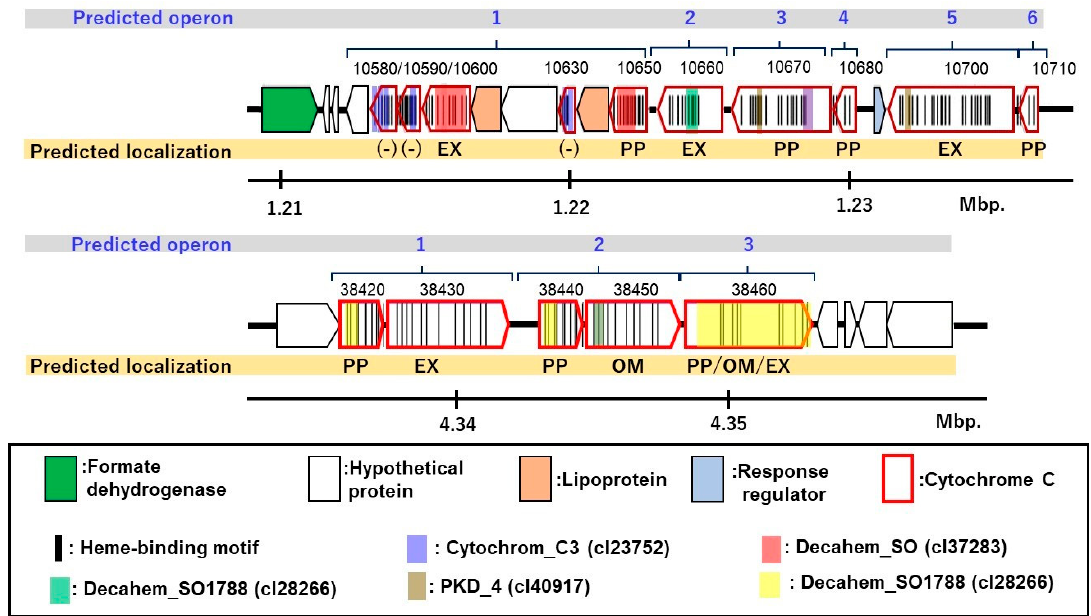
Figure 6. Two predicted gene clusters of unique c -type cytochrome C in strain